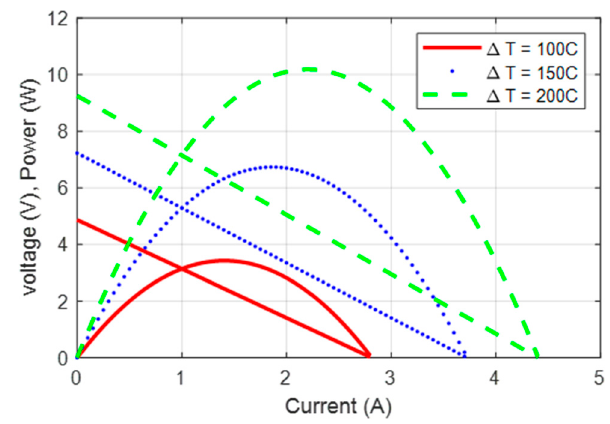
Figure 1. Typical electrical characteristics of thermoelectric generators (TEG).